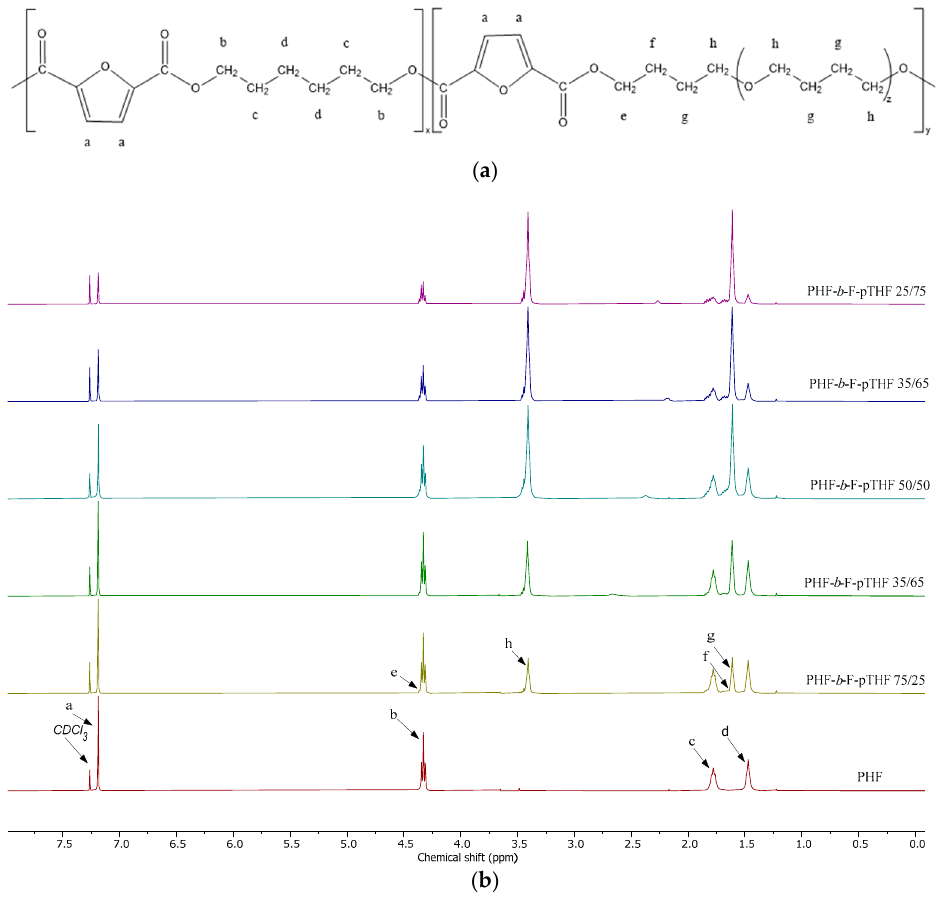
Figure 3. Structure of PHF- b -F-pTHF copolymers ( a ) and nuclear magnetic resonance (NMR) spectra of PHF- b- F-pTHF copolymers ( b ). Table 1. Composition and molecular characterization of poly(hexamethylene 2,5-furanodicarbox-